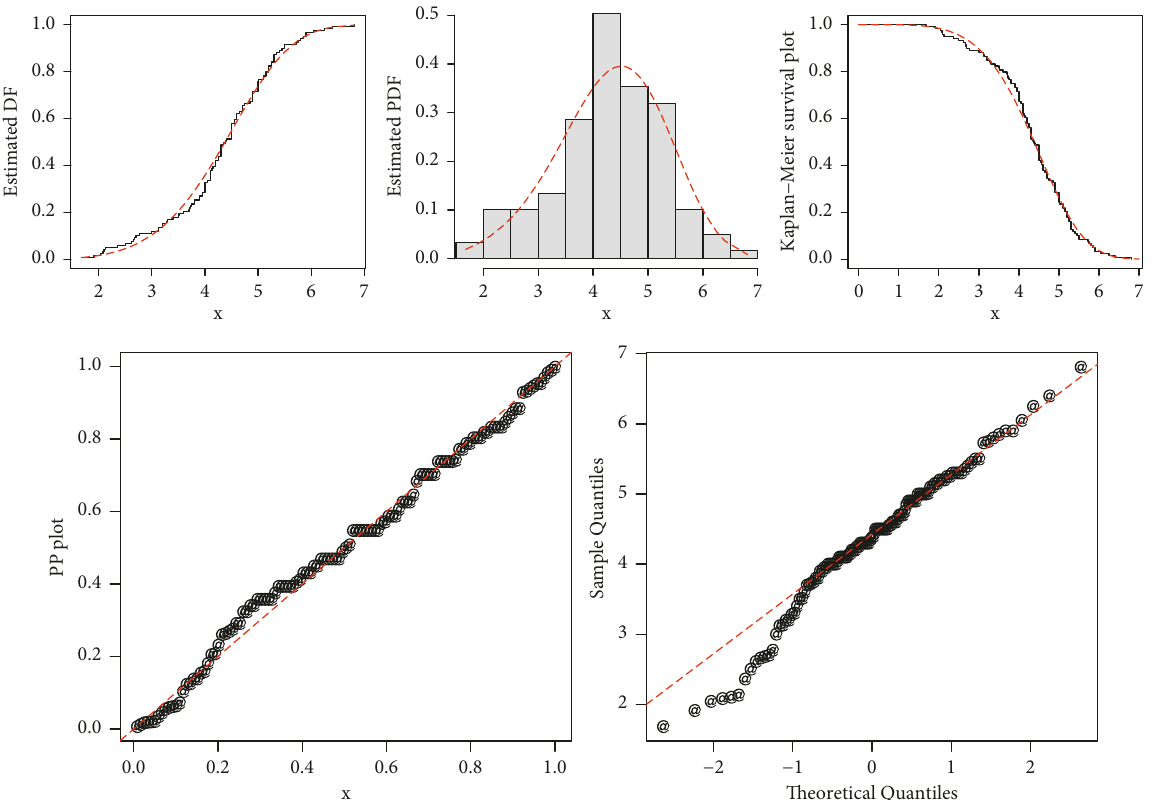
Figure 3: Visual performances of the NGExp-Weibull model for the Al